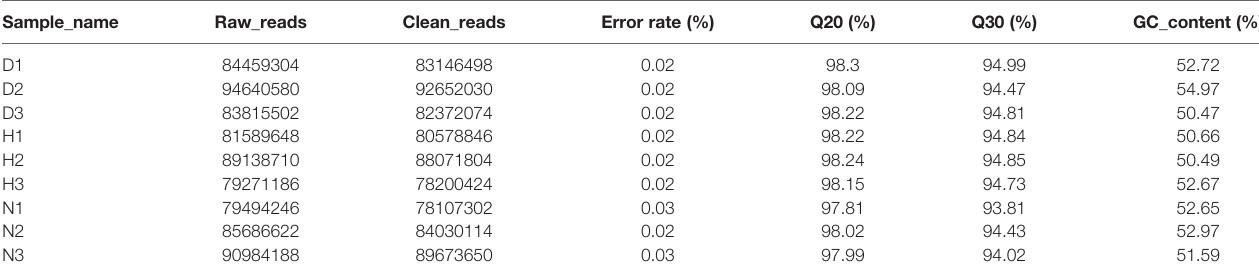
TABLE 2 | Overview of mRNA sequencing data of every groups.